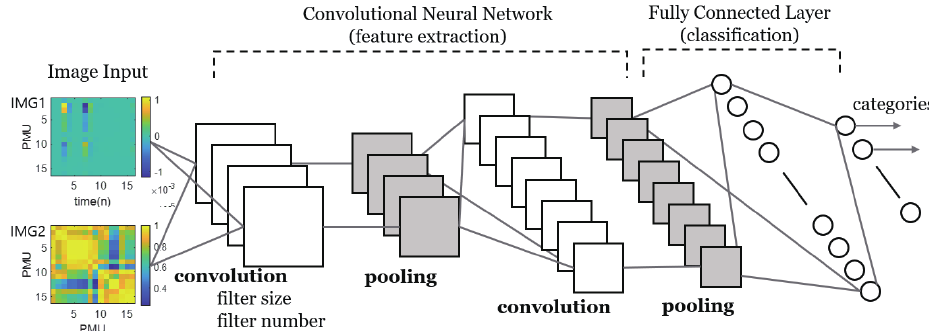
Figure 2. The structure of the single channel CNN classification using single image